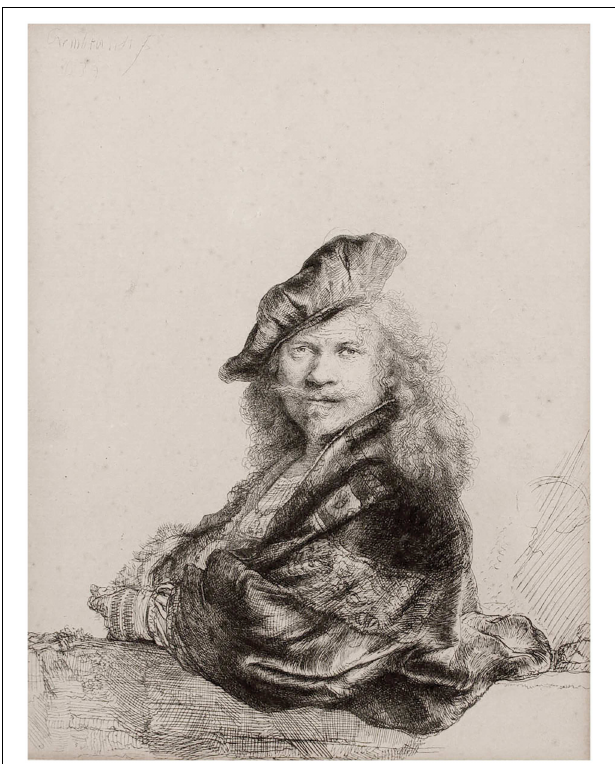
FIGURE 1 | Rembrandt van Rijn, Self-portrait leaning on a stone sill, 1639, etching on paper. Photograph of a reproduction owned by the author.